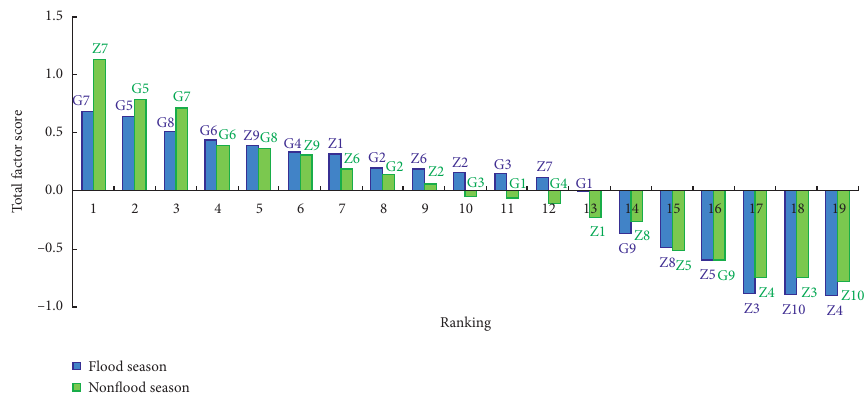
Figure 6: Total factor scores of contamination at monitoring